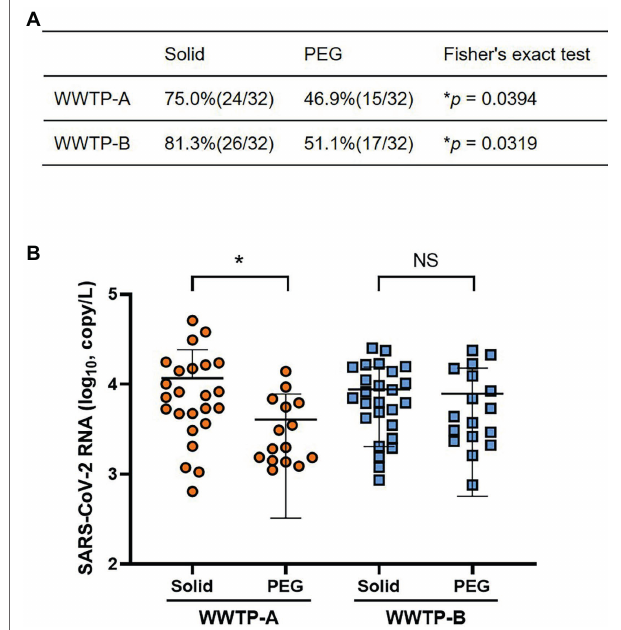
FIGURE 2 | Detection of SARS-CoV-2 RNA in the solid and PEG- precipitated fractions. (A) Positivity rate of SARS-CoV-2 RNA in the solid and PEG-precipitated fractions. Values of p were calculated using Fisher’s extract test. (B) The SARS-CoV-2 RNA copy number of positive samples in solid and PEG-precipitated fractions from WWTP-A (orange circles) and WWTP-B (blue squares) were quantified using RT-qPCR. Bars indicate the mean ± SD. Statistical significance was calculated using the Mann–Whitney U test. * p < 0.05, NS, not